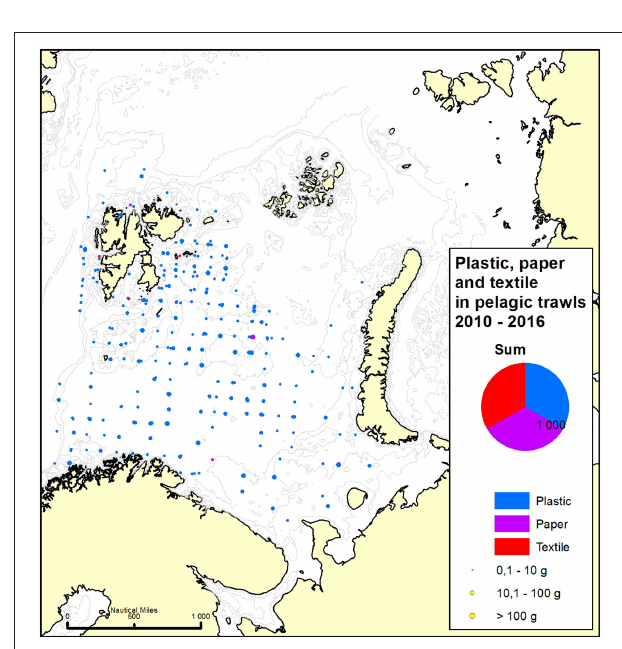
FIGURE 3 | Marine litter from surface observations 2010 to 2016. Observations of plastics (blue), wood (green) and metal (red).